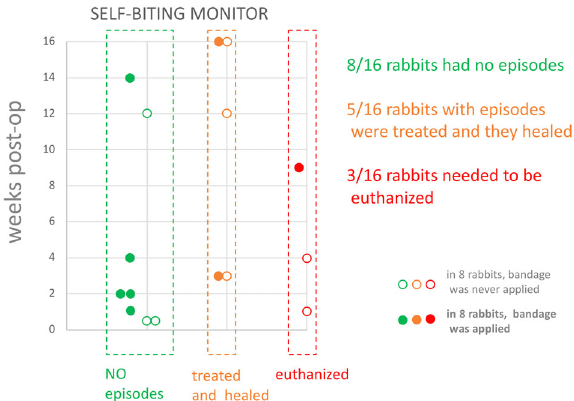
Fig. 7 Episodes of self-mutilation showed that half of the rabbits did not exhibit any self-mutilation behavior at all. Five self-mutilation episodes were treated with medication and were followed by healing. Three self-mutilation episodes led to the rabbit ’ s euthanasia. Self- mutilation episodes were quite evenly distributed along the 16 weeks. Prophylactic bandaging of the surgical limb was utilized in half of the rabbits but an acute episode was observed even with the presence of the bandage and required